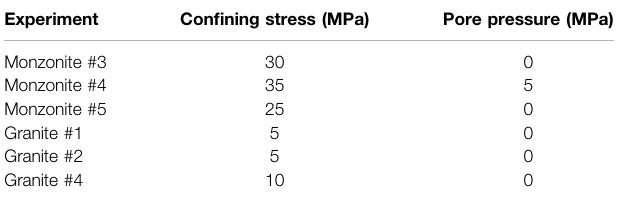
TABLE 1 | Conditions of each